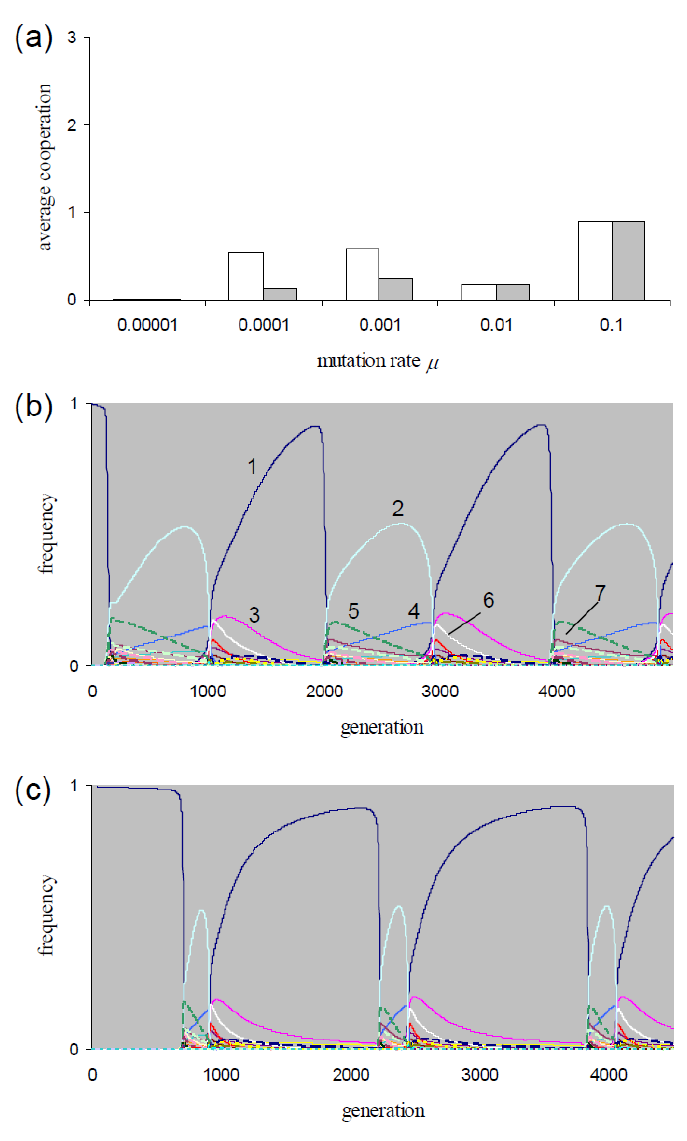
Figure 1. ( a ) Average execution of cooperation per game ( C ) as function of mutation rate in X3 -simulations of dgm -populations (white) and of cgm -populations (gray). For rates µ = {10 − 5 , 0.01, 0.1}, averages are sampled at equilibrium, and for rates µ = {0.0001, 0.001}, averages are sampled over a cycle period (see panel ( b , c )). Fixed parameters: P = 0.05, T = 5, S = 0, R = 3, K = 0; ( b ) For the conditions of panel ( a ), the frequency dynamics of an evolving dgm -population at rate µ = 0.001. 1: ddddddd ( AllD ); 2: cdddddd ( TfT 1); 3: ddddddc ; 4: ddcdddd ; 5: cdcdddd ( TfT 2); 6: dcddddd ; 7: dccdddd ; ( c ) For the conditions of panel ( a ), the frequency dynamics of an evolving cgm -population at rate µ = 0.001. Panel ( b , c ) use the same line code. Table 4. List of strategies that obtain peak frequencies higher than 0.1 (max( f i ) > 0.1) within the cycle phases of the dgm -dynamics depicted in Figure 1b. Code representation (conventional name in